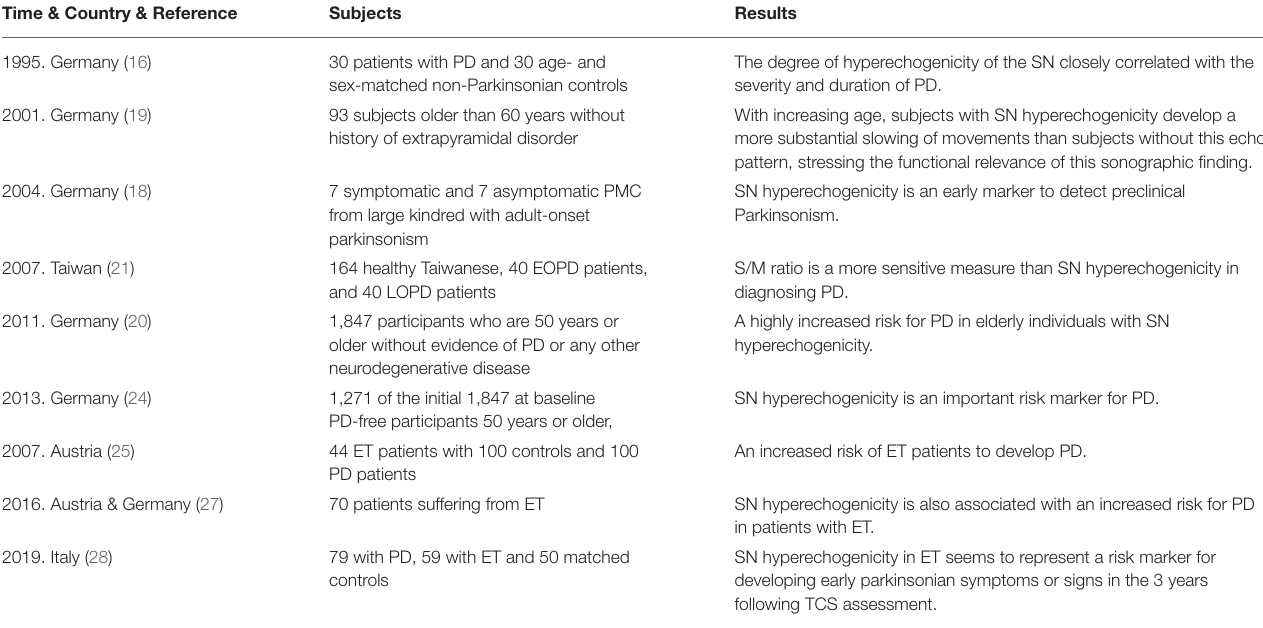
TABLE 1 | Studies on SN hyperechogenicity indicate a role in prediction of the risk of PD. Time & Country & Reference Subjects